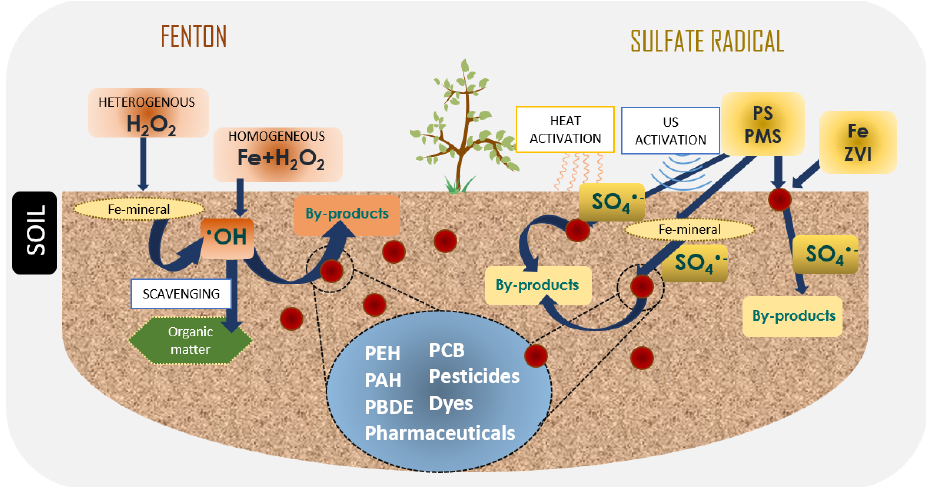
Figure 4. Mechanisms of Fenton and sulfate radical processes in organics-polluted soil.